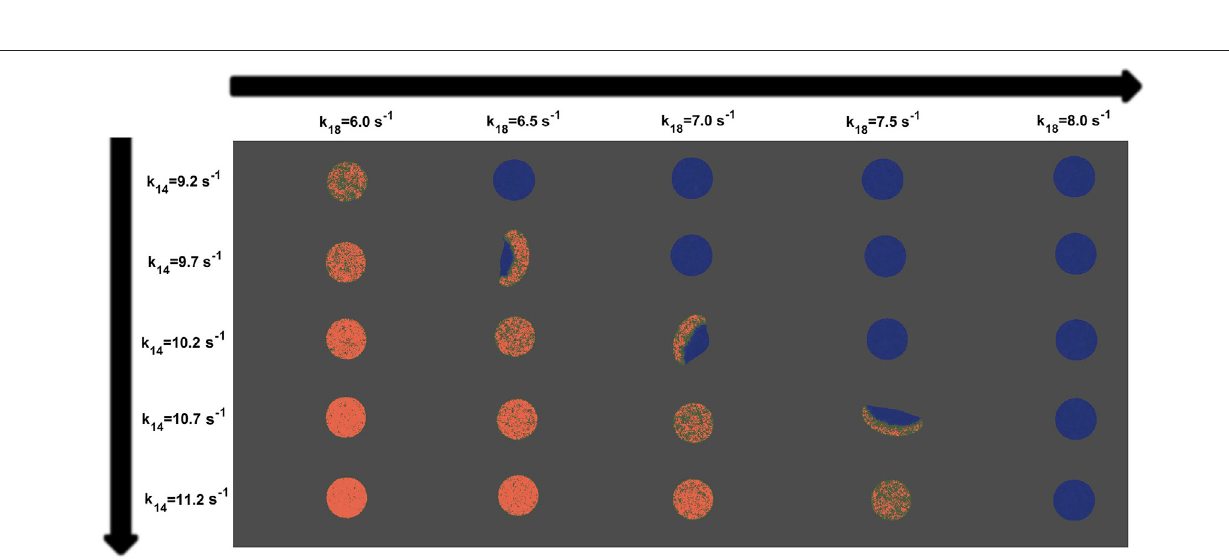
FIGURE 4 | Snapshots of the virtual cells showing P (in red) obtained from computer simulations and applying the phase fi eld technique to the model for different values of k 14 and k 18 . Variances of noise intensity were fi xed at σ R = 0.04 and σ P = 0.025. The rest of them are consistent with Supplementary Table S1